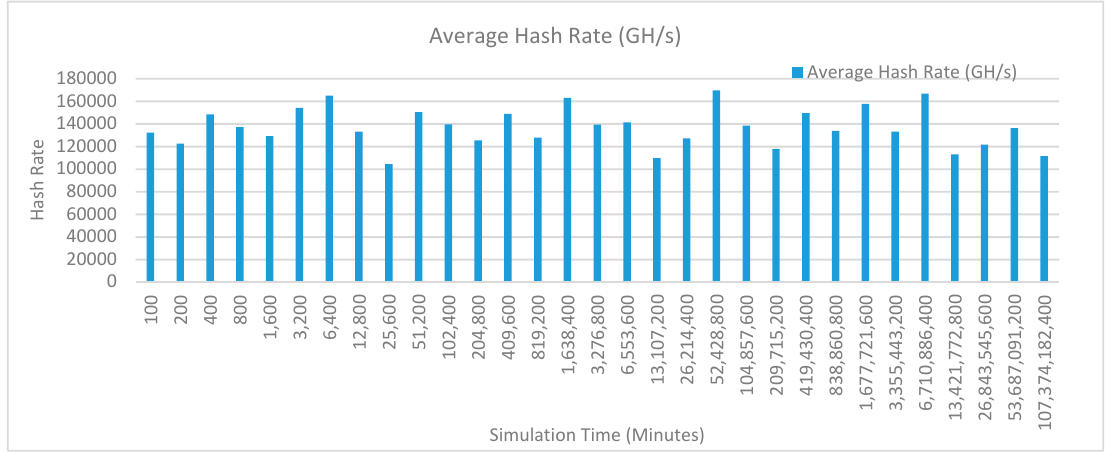
Figure 19. Average hash rate analysis (with IoT, edge, fog).